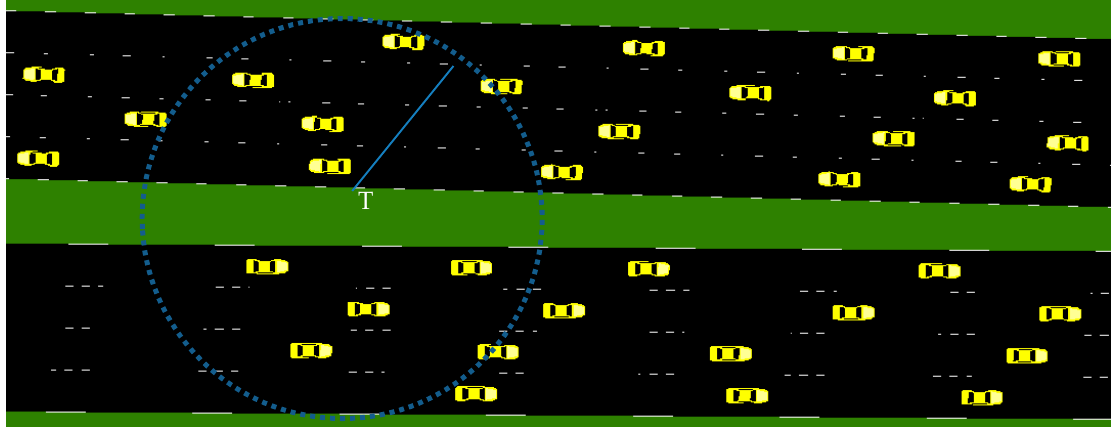
Figure 1. Network model: simulation of highway with 4 lanes in each direction.